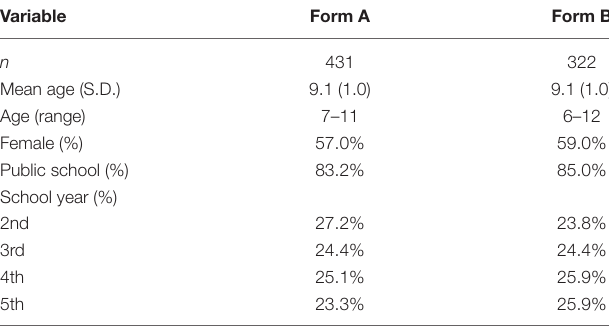
TABLE 1 | Sample characterization per form of the test.